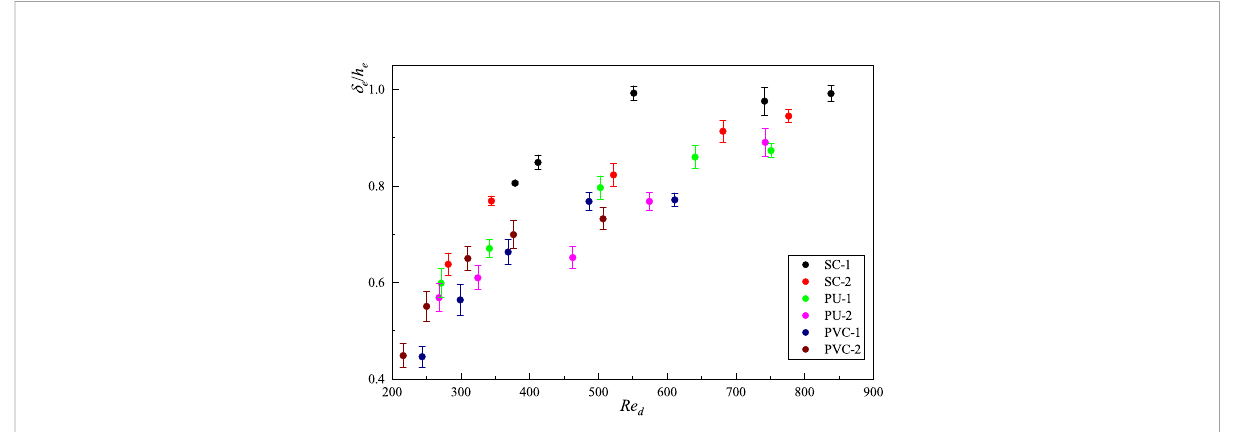
FIGURE 4 The relationship between dimensionless penetration depth, d e / h e , and vegetation canopy Reynolds number, Re d , under different test